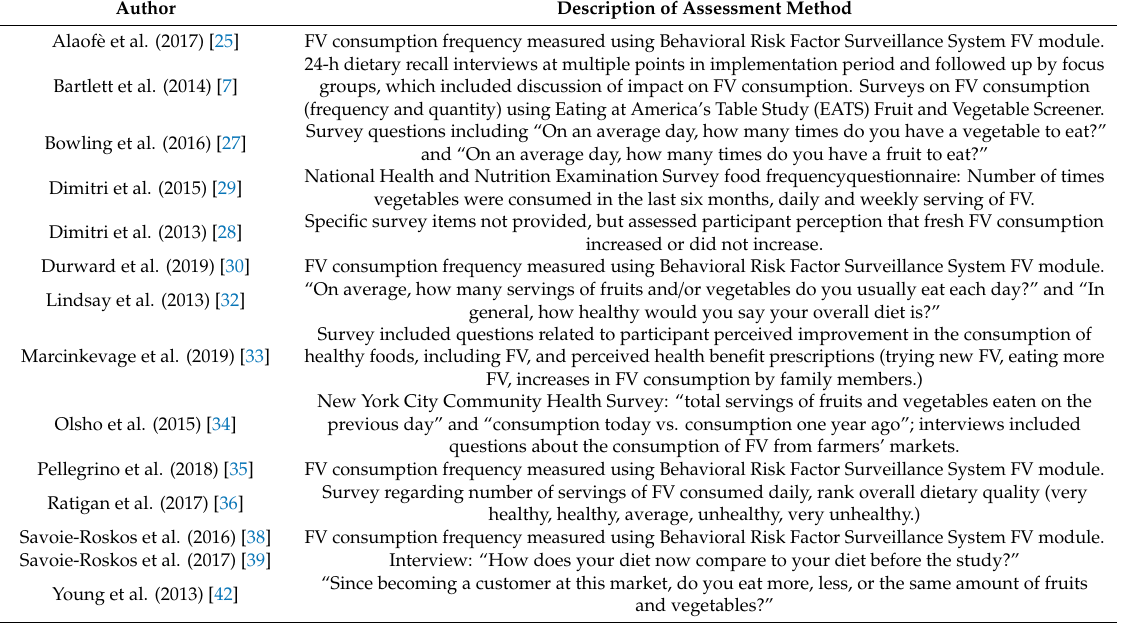
Table 3. Assessment of fruit and vegetable consumption in nutrition incentive